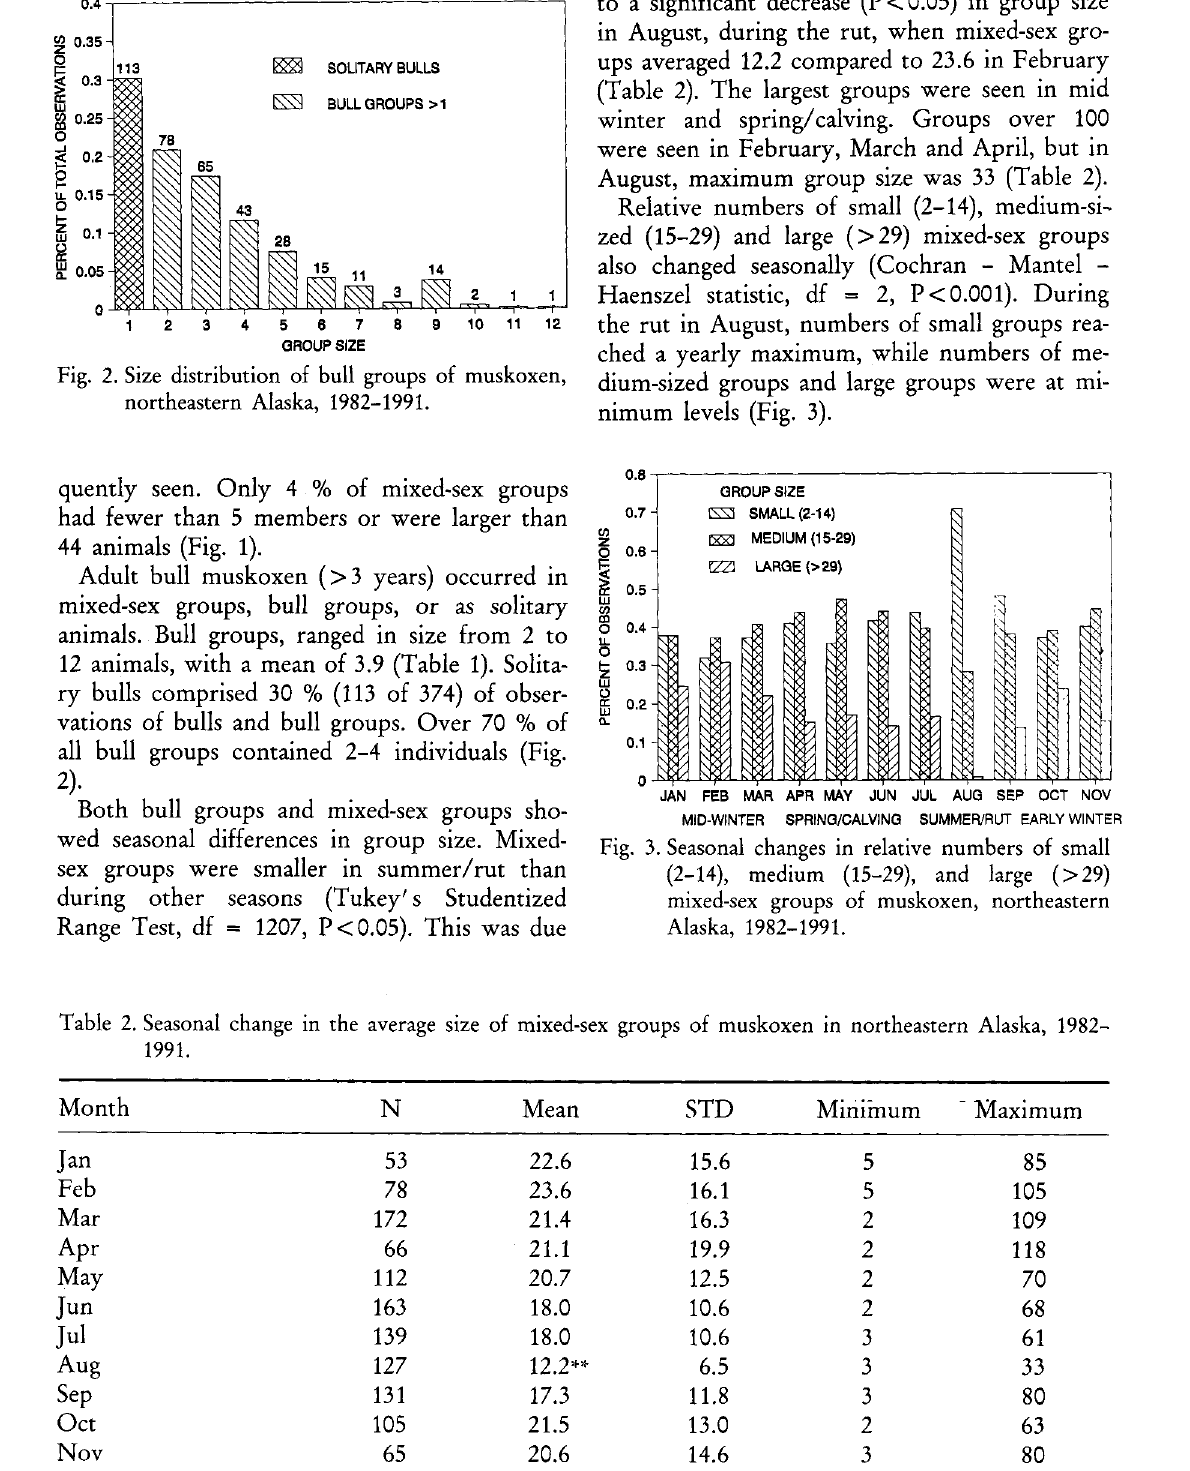
Fig. 2 . Size distribution of bull groups of muskoxen, northeastern Alaska, 1982-1991.